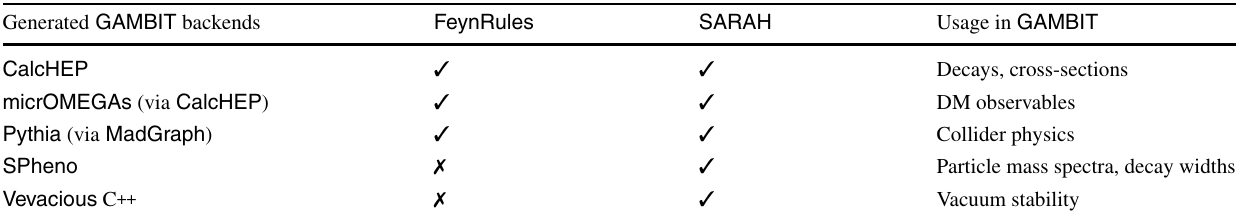
Table 1 GAMBIT backends with GUM support and Lagrangian-level tools used to generate them. Apart from the external packages listed, GUM also produces GAMBIT Core and physics module code tailored to the model and observables of interest Generated GAMBIT